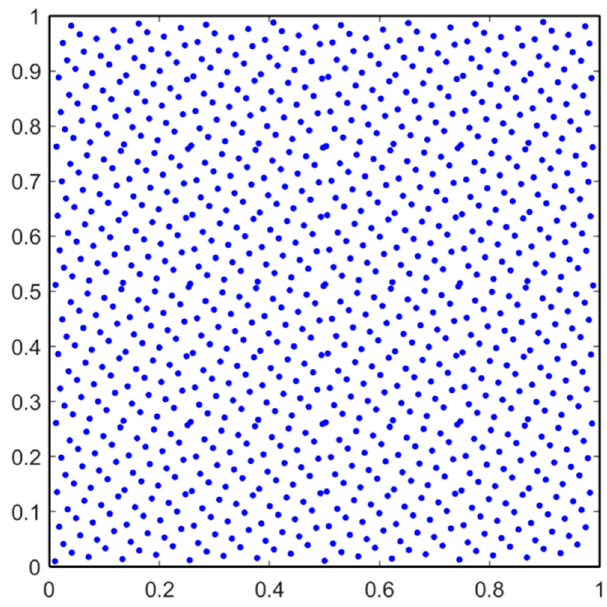
Figure 3. Hammersley distribution of residual points for the PINN model.